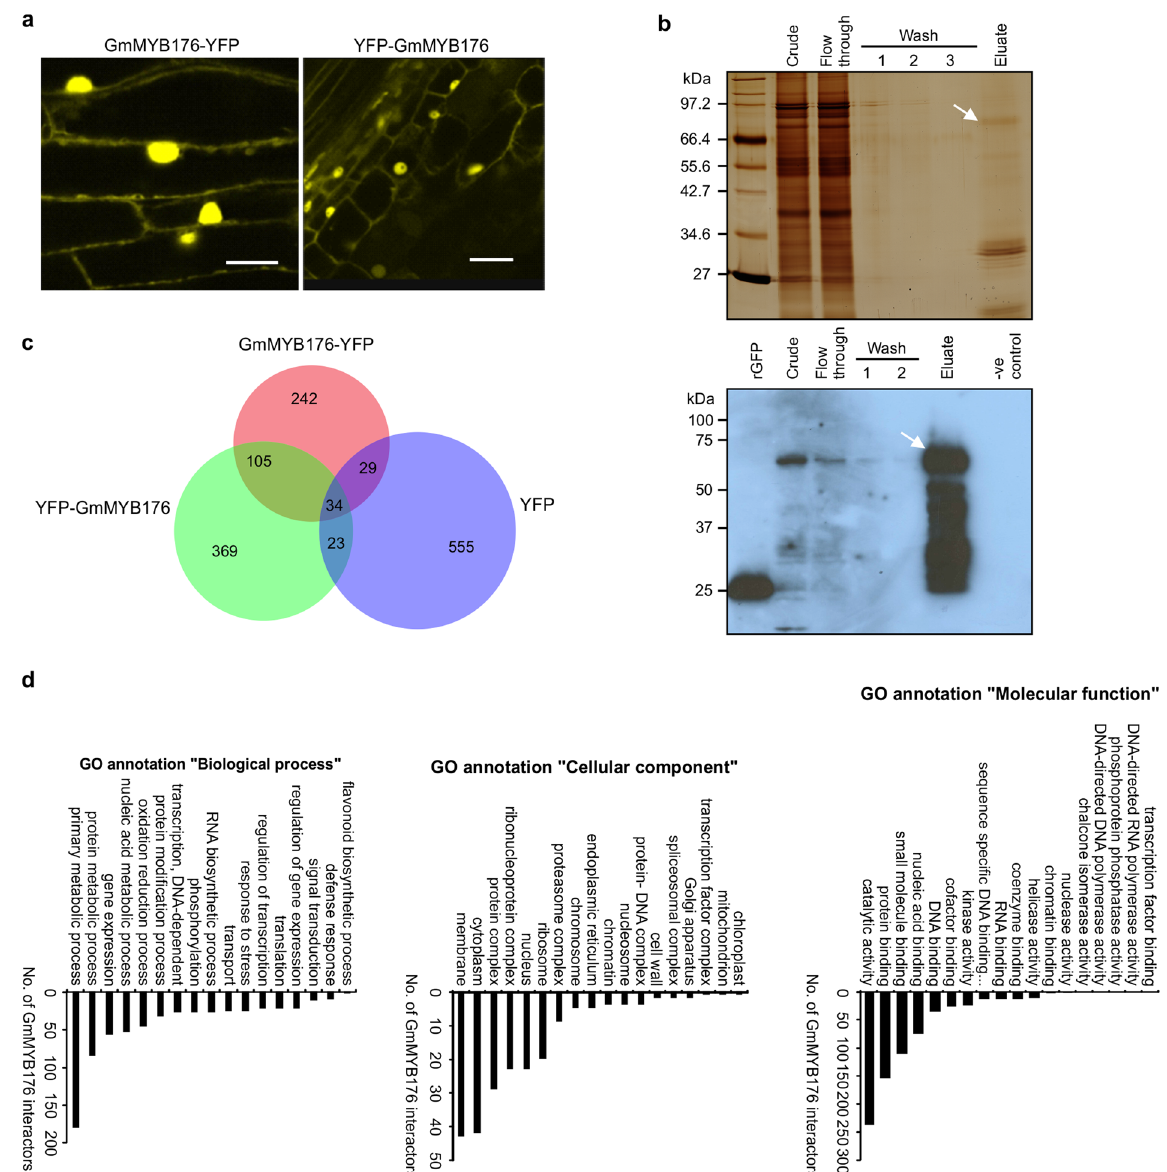
Fig. 1 Co-immunoprecipitation of GmMYB176 interacting proteins from soybean hairy roots. a Subcellular localization of GmMYB176-YFP and YFP- GmMYB176 in hairy roots. Both GmMYB176-YFP and YFP-GmMYB176 fusion proteins were localized in the nucleus and the cytoplasm of soybean hairy root cells as observed by confocal microscopy. Scale bar = 50 μ m. b Crude protein extracts were subjected for Co-IP assay using anti-GFP microbeads and µ MAC epitope tag protein isolation system. Samples from each step were separated on an SDS-PAGE and visualized by silver staining (top gel). The bottom image shows Western blot analysis using anti-GFP monoclonal antibody. The arrow indicates the estimated size of GmMYB176-YFP protein in the eluate. Crude: crude protein extract from soybean hairy roots; Flow through: crude extract incubated with anti-GFP microbeads and applied to μ column, with the fl ow through collected; Wash: sequential wash steps with lysis buffer; Eluate: elution of bound proteins from the column; – ve control: crude extract from control hairy roots. c Venn diagram showing the overlap of GmMYB176-YFP, YFP-GmMYB176, and YFP-only interacting candidate proteins in soybean hairy roots identi fi ed by LC – MS/MS analysis. The YFP interacting protein candidates were obtained from our previous study 21 . d ‘ GO ’